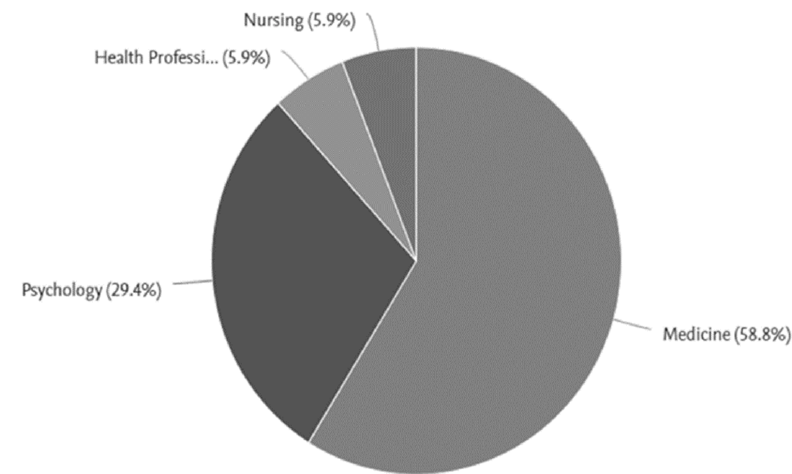
Figure 3. Knowledge areas.